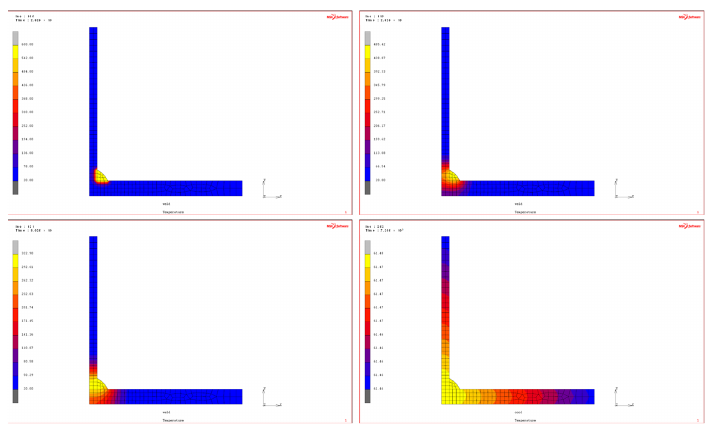
Figure 13. Results of thermal FE analysis (Al 6061 T6).